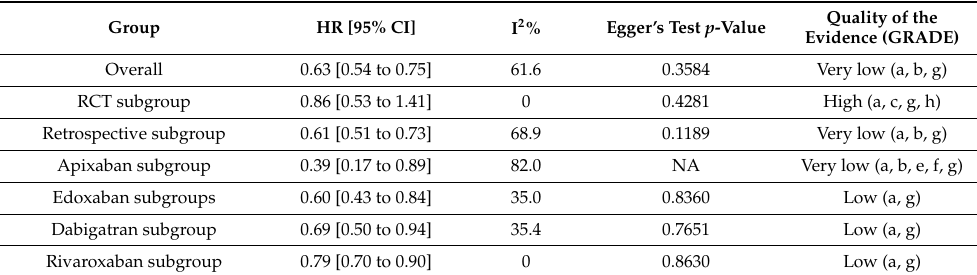
Table 2. Meta-analyses of gastrointestinal bleeding in different groups.